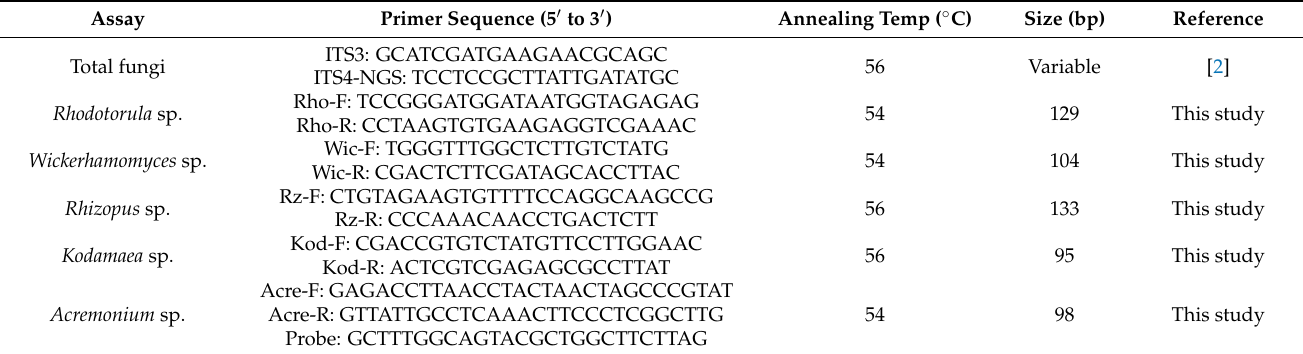
Table 1. List of primers and probe sequences for quantitative real-time polymerase chain reaction. Assay Primer Sequence (5 (cid:48) to 3 (cid:48) ) Annealing Temp ( ◦ C) Size (bp)